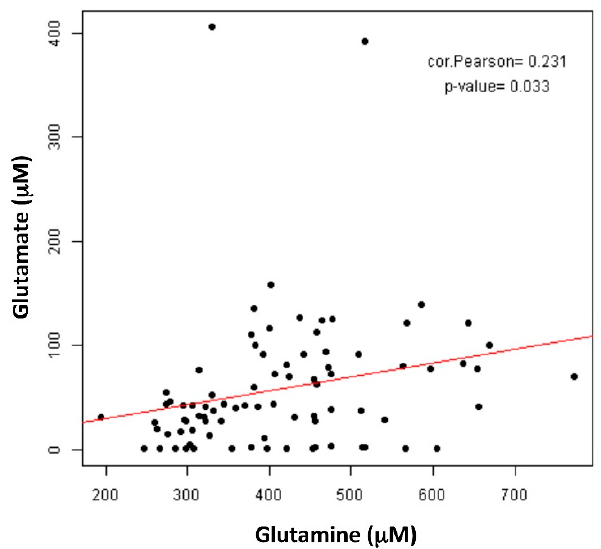
Figure 3. Correlation between glutamine and glutamate plasma levels. Pearson’s coefficient (cor) and p -value are shown.